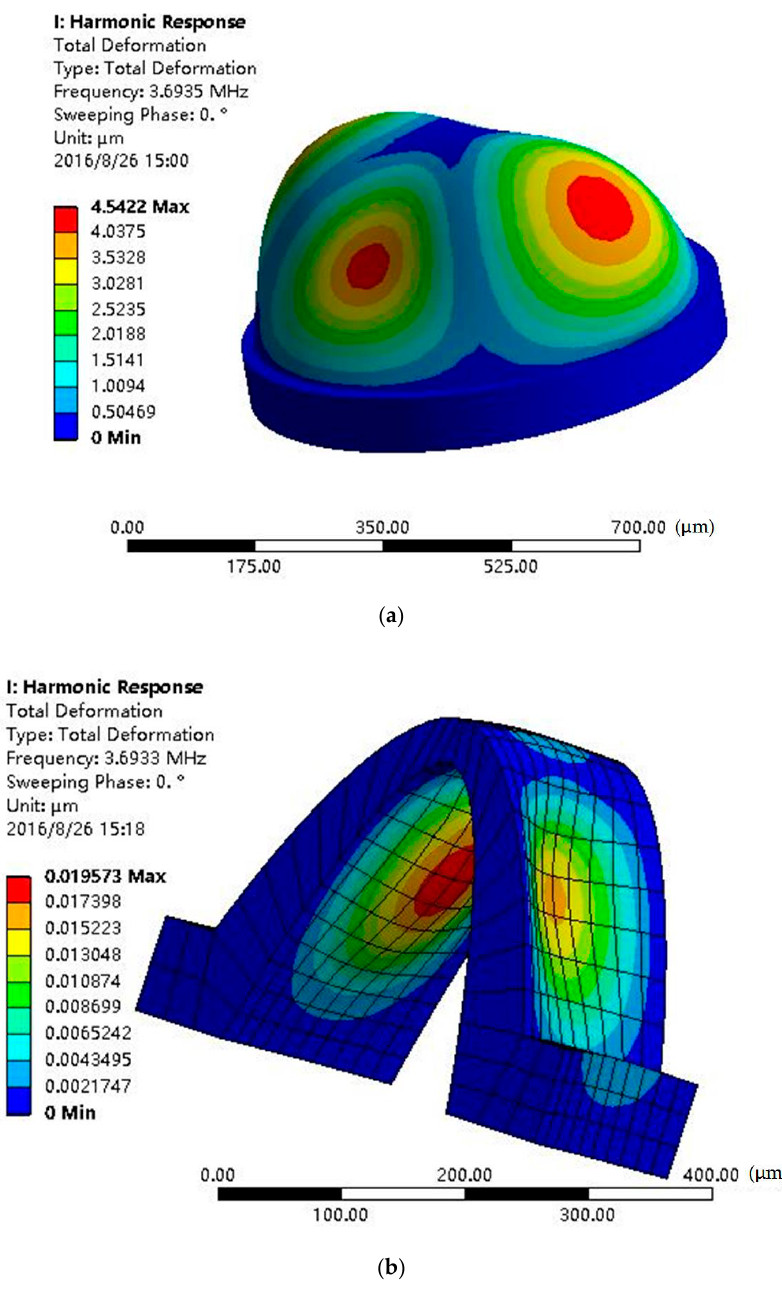
Figure 4. Applied with the same force, max deformations of the shell ( a ) and electrode ( b ) are 4.542 μ m and 0.019 μ m, respectively.